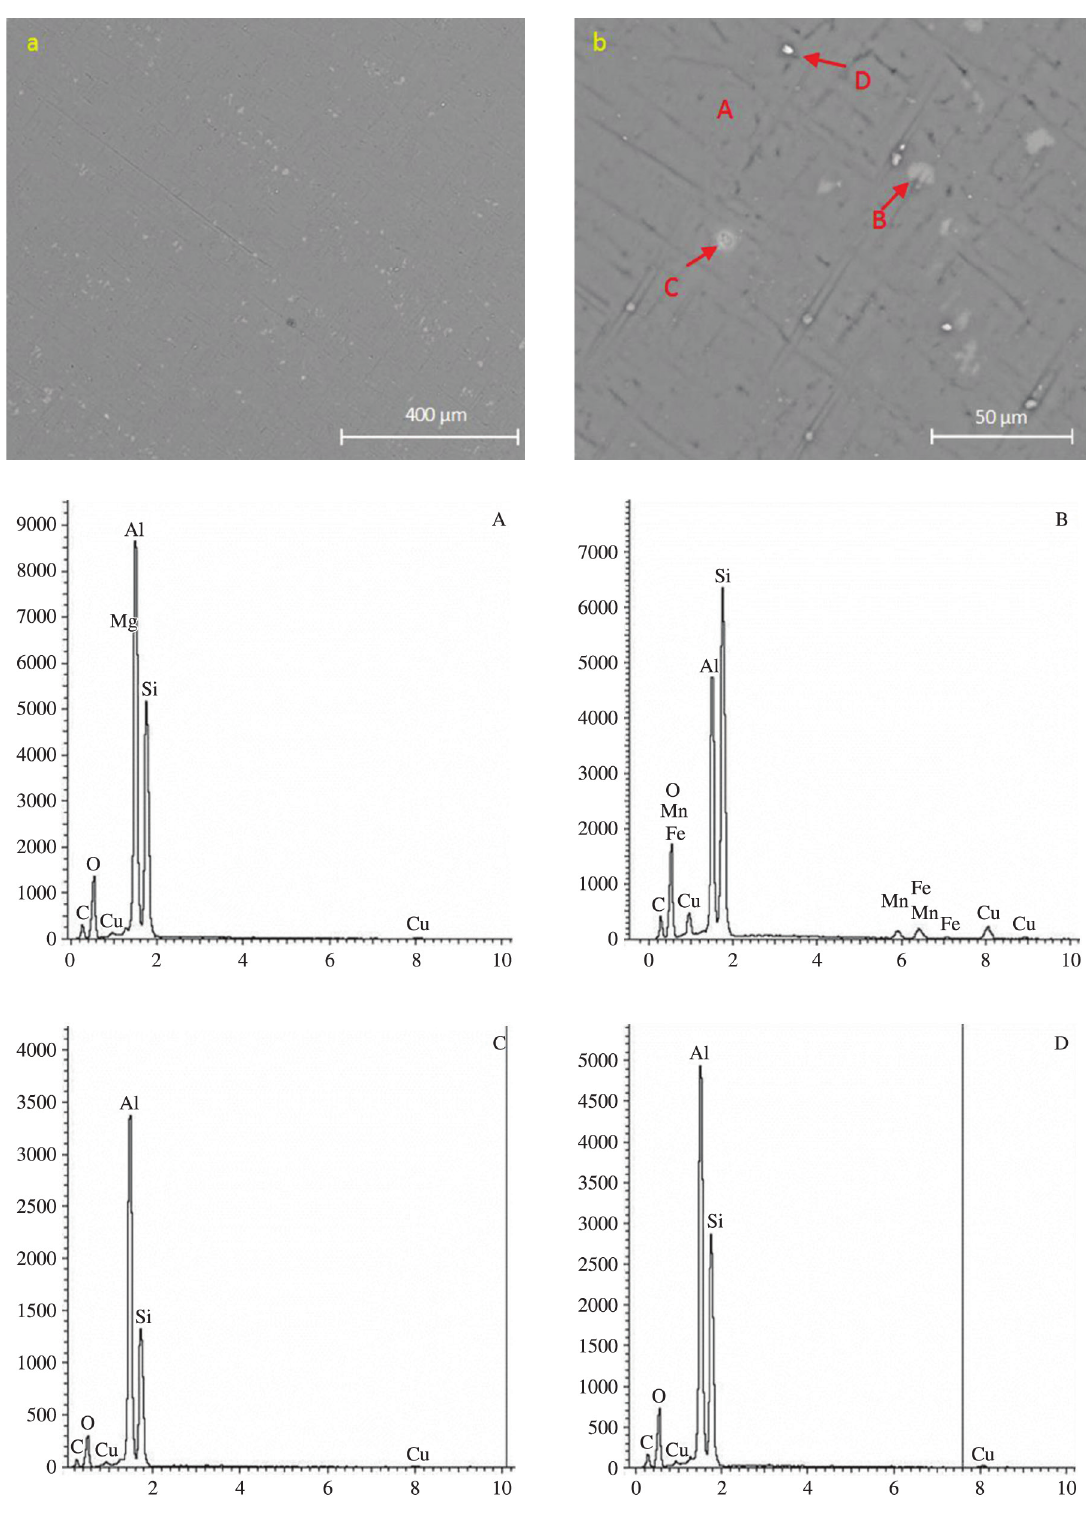
Figure 24. Scanning electron micrograph of the sample containing the film deposited with discharge power of 50 W with amplification of (a) 250 times and (b) 1500 times. A, B, C and D are energy dispersive spectra of the regions A, B, C and D of the micrograph shown in